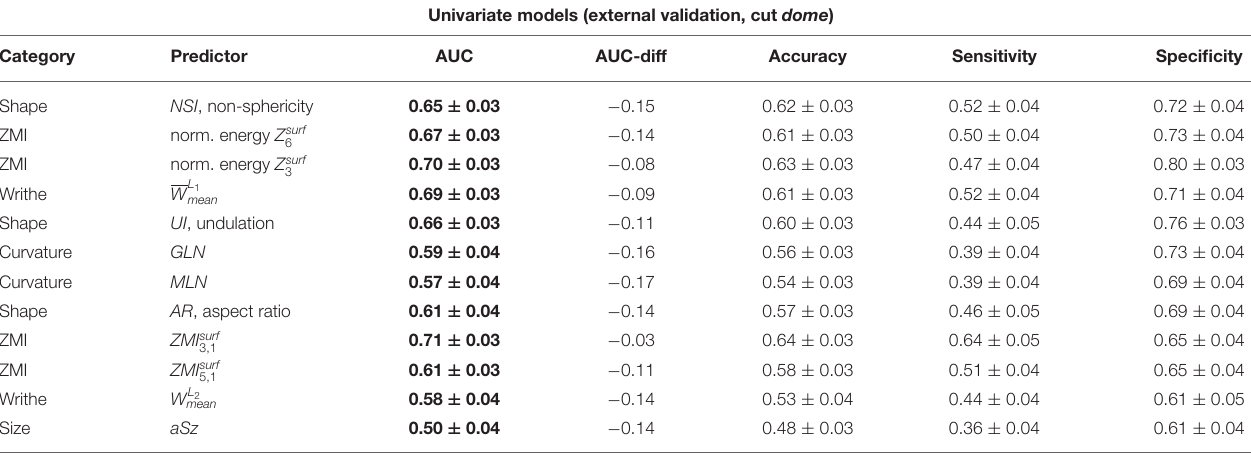
TABLE 7 | External validation results of the same univariate predictors of Table 5 .